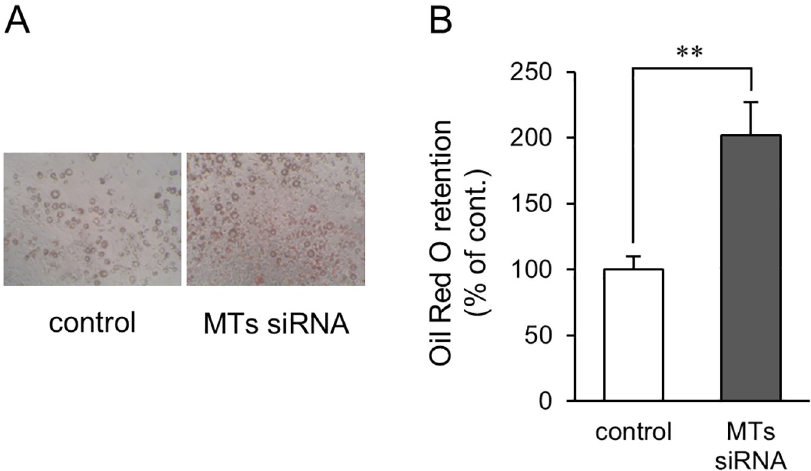
Fig 4. Effect of MTs siRNA on lipid accumulation in 3T3-L1 adipocytes. 3T3-L1 preadipocytes were treated with 50 nM control RNA or MTs siRNA 24 h before the inductionof differentiation. On day 2, the culture medium was changedto medium supplemented with 1 μ g/ml insulin. On or after day 4, the medium was replacedevery 2 days. Naturallipids in the fixed cells were stained with Oil Red O. (A) Representative images of Oil Red O stainingof 3T3-L1 adipocytespretreatedwith control RNA (control) or MTs siRNA. (B) Absorbance of Oil Red O was measured, and Oil Red O retention is expressedas a percentage relative to the control RNA-treated cells. Data are expressedas the mean ± SD ( n = 5). ** representsa P value of < 0.01.